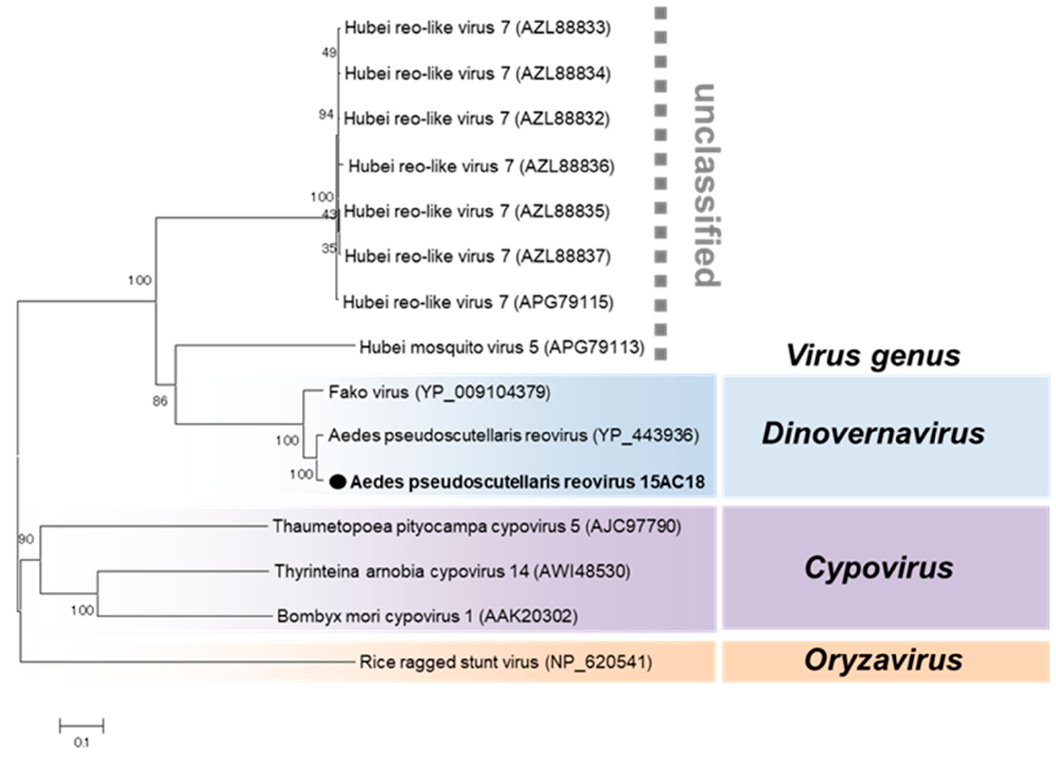
Figure 12. Phylogenetic analysis of Aedes pseudoscutellaris reovirus (APRV). Maximum likelihood tree of APRV constructed with conserved amino acid domains in the RdRp (VP2) extracted using MAFFT 7 online version [27] and the Gblocks program [28]. Bootstrap support values from 1000 bootstrap replicates are indicated on the branches. The GenBank accession number of the RdRp (L segment) sequence used is LC496849.